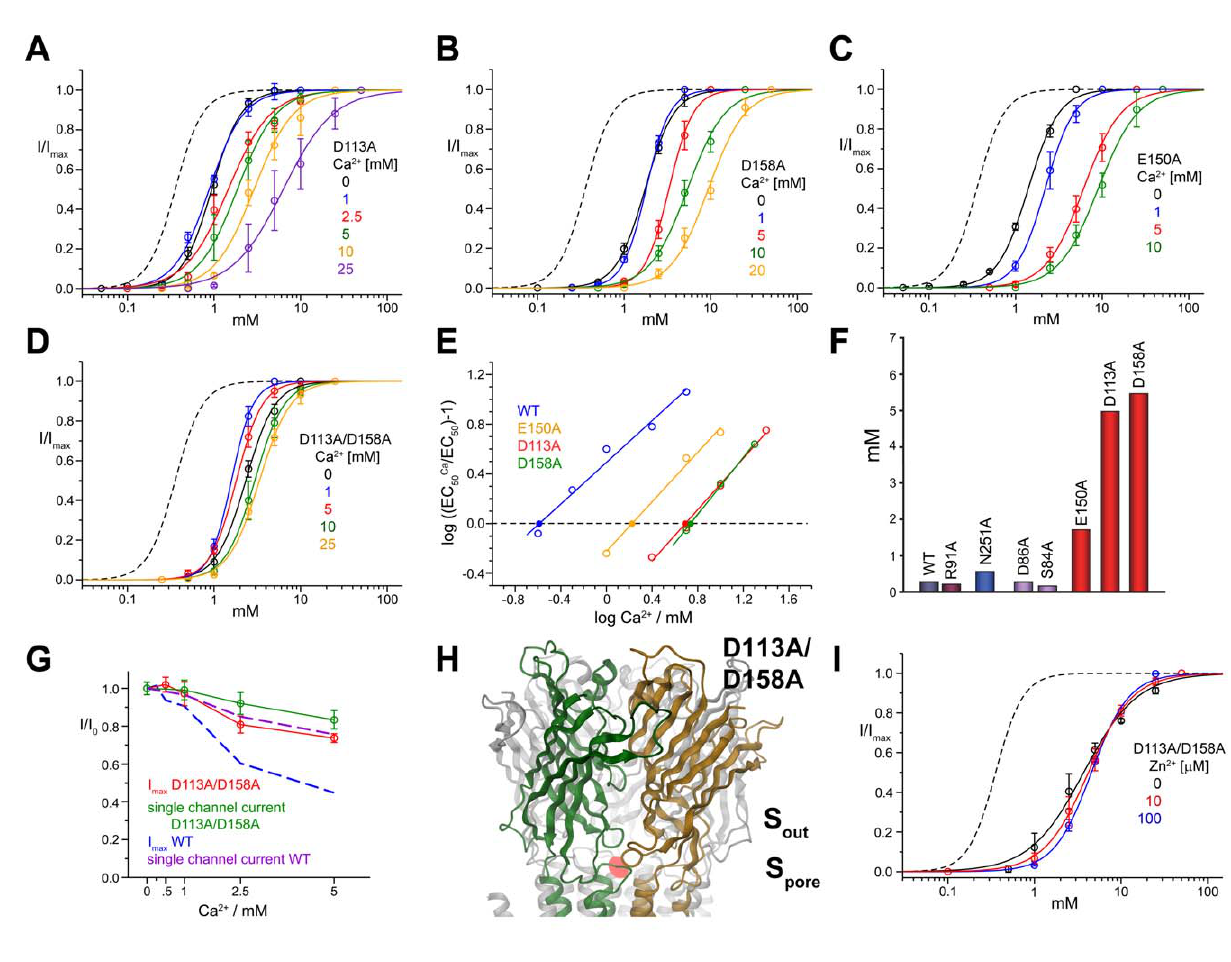
Figure 5. Divalent ion inhibition in mutants of the regulatory site S out . Dose–response relationships of the ELIC mutants D113A (A) and D158A (B), E150A (C), and the double mutant D113A/D158A (D) activated by cysteamine at different concentrations of Ca 2 + are shown. (E) Schild plots N quantifying the inhibition of ELIC mutants by Ca 2 + . EC 50 values were obtained from data shown in panels (A–D). Potencies of the antagonists (pA ). WT is shown for comparison. (F) Graphical depiction of values) were obtained by linear regression; the intersection with the x -axis is indicated ( potencies for Ca 2 + inhibition in different mutants. (G) Maximum current response of the double mutant D113A/D158A at different Ca 2 + concentrations. The currents are normalized to the maximum response in the absence of Ca 2 + . Whole cell currents measured at 2 40 mV with the two-electrode voltage clamp technique are shown in red (the averages of at least 5 oocytes are shown; errors are SD). Single channel currents from the double mutant D113A/D158A were measured in the outside-out configuration and are shown in green. WT macroscopic and single channel currents are shown as dashed lines for comparison. (H) Anomalous difference electron density (calculated at 5 A ˚ and contoured at 5 s ) from data of the double mutant D113A/D158A in complex with Ba 2 + is superimposed on a model of ELIC in ribbon representation. Ion-binding sites are indicated. (I) Dose–response relationships of the double mutant D113A/D158A activated by propylamine at different concentrations of Zn 2 + . The data presented in panels (A–D) and (I) are averages from at least 5 oocytes; errors are SD. The solid lines show fits to a Hill equation. Currents were recorded at 2 40 mV. A dose–response curve of WT in the absence of Ca 2 + (dashed line) is shown for comparison.